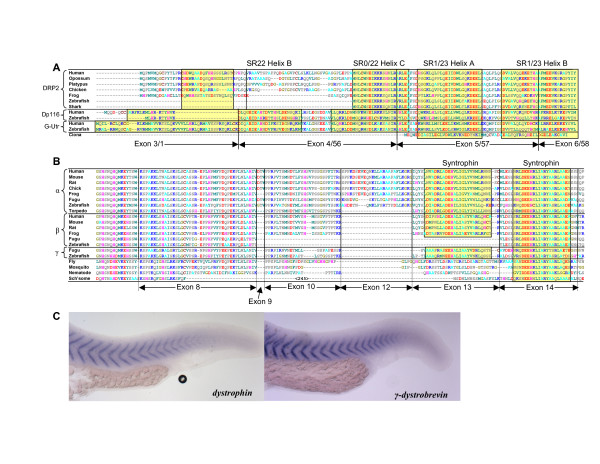
DRP2 and vertebrate dystrobrevins. A) Relationship between DRP2, Dp116 and G-utrophin. Alignment of N-terminal DRP2 sequences from a range of animals, together with selected dystrophin Dp116 and G-utrophin sequences. Accession numbers: H. sapiens DRP2, [GenBank:U43519]; Ornithorhyncus anatinus DRP2, [GenBank:BK005803]; G. gallus DRP2, [GenBank:DR425253]; X. tropicalis DRP2, [GenBank:CX826467];D. rerio DRP2, [GenBank:DQ443728]; S. canicula DRP2, [GenBank:U43517]; H. sapiens Dp116, [GenBank:NM_004014]; D. rerio Dp116, [GenBank:DQ788695]; H. sapiens G-utrophin, [GenBank:BP282211]; D. rerio G-utrophin, [GenBank:DQ788696]. Other sequences were predicted from publicly available genome data. Yellow boxes indicate helical regions (PSIPRED) annotated with spectrin repeat (SR) numbers for dystrophin and DRP2[24] where applicable. Exon numbers for dystrophin and DRP2 are given [4, 81]. B) Alignment of alternatively spliced region of selected dystrobrevin sequences. All full-length coding exons (numbering after mouse α-dystrobrevin, Ambrose et al., 1997 [33]) have been included (the status of the 9-bp exon 9 is not known for frog and torpedo α-dystrobrevin; exon 11 is only used in a C-terminally truncated α-dystrobrevin isoform). Exon boundaries only apply to vertebrate genes; the region corresponding to exons 8–14 is encoded by a single exon in the four invertebrates. Yellow boxes indicate syntrophin binding sites [39]. Accession numbers as follows; α-dystrobrevins: H. sapiens, [GenBank:NM_001390]; M. musculus, [GenBank:AF143543]; R. norvegicus, [GenBank:XM_226109]; X. laevis [GenBank:BC046265];D. rerio, [GenBank:DQ516343] and [GenBank:DQ516344]; T. californica, [GenBank:L06945]; β-dystrobrevins:H. sapiens, [GenBank:Y15722]; M. musculus, [GenBank:Y15742]; R. norvegicus, [GenBank:BC081889]; D. rerio, [GenBank:DQ516345]; D. rerio γ-dystrobrevin, [GenBank:DQ516346]; D. melanogaster dystrobrevin, [GenBank:AF277387]; C. elegans dystrobrevin, [GenBank:NP_490860]; S. mansoni dystrobrevin, [GenBank:DQ431251]. Other sequences were predicted from publicly available genome and EST data. C) Results of in situ hybridisation of probes complementary to the 3'UTRs of zebrafish dystrophin and γ-dystrobrevin transcripts. Wholemount 24 hpf embryos are shown, anterior to the left. The dystrophin staining of vertical myosepta, comparable to that previously described [32], is similar to that obtained with γ-dystrobrevin.